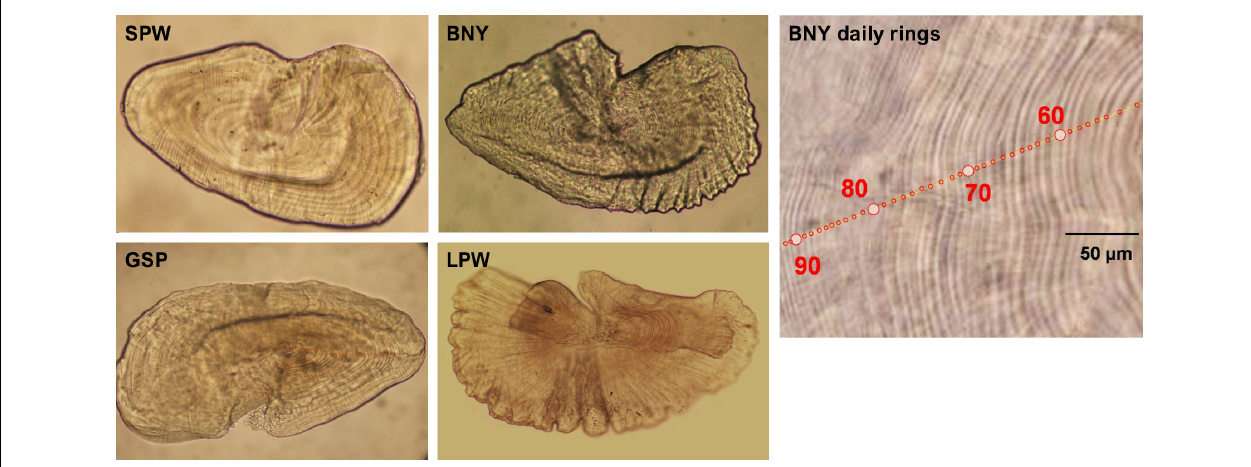
FIGURE 4 | Mounted asteriscus of spotwing flyingfish (SPW, 30.24 mm FL), bony flyingfish (BNY, 54.21 mm FL), greater spotted flyingfish (GSP, 49.32 mm FL), and limpidwing flyingfish (LPW, 286.2 mm FL). “BNY daily rings” is part of the asteriscus of BNY of 155.01 mm FL under a zoom stereomicroscope (SMZ1000, Nikon), with increment counts in red